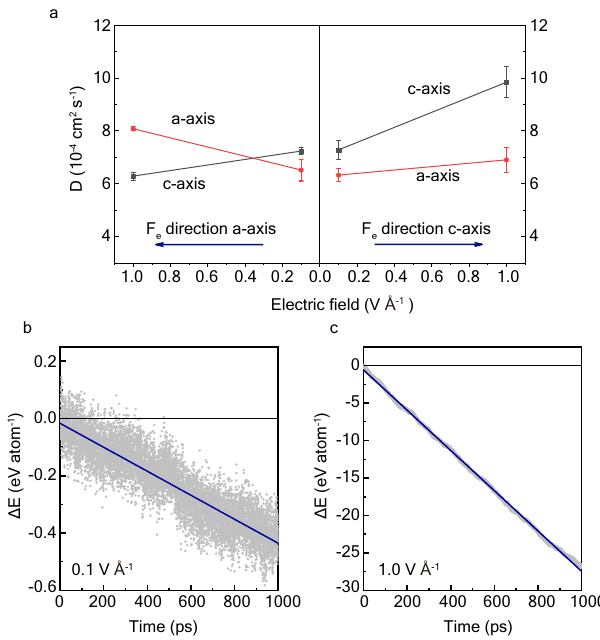
Fig. 3 | H-ion diffusion anisotropy and energy differences in hcp-FeH 0.25 under externalelectric fi elds.a H-iondiffusionanisotropychangeswiththeintensityand direction of the external electric fi elds. Diffusion coef fi cients along the a-axis and c-axis directions are shown with red and black symbols. The electric fi eld (F e ) directionsareshownwithbluearrows.Theerrorbarsindicatethevariationoflinear Δ E=E fi tting of MSD data. b , c Energy difference of FeH 0.25 ( c-axis -E a-axis ) under the electric fi eld of 0.1VÅ − 1 and 1.0VÅ − 1 . The calculated energies are shown with gray dots, and the changes in Δ E with simulation time are linearly fi tted with blue lines. Thenegative Δ E(belowtheblackline)indicatesthatthec-axisofFeH 0.25 parallelto the external fi eld direction is energetically